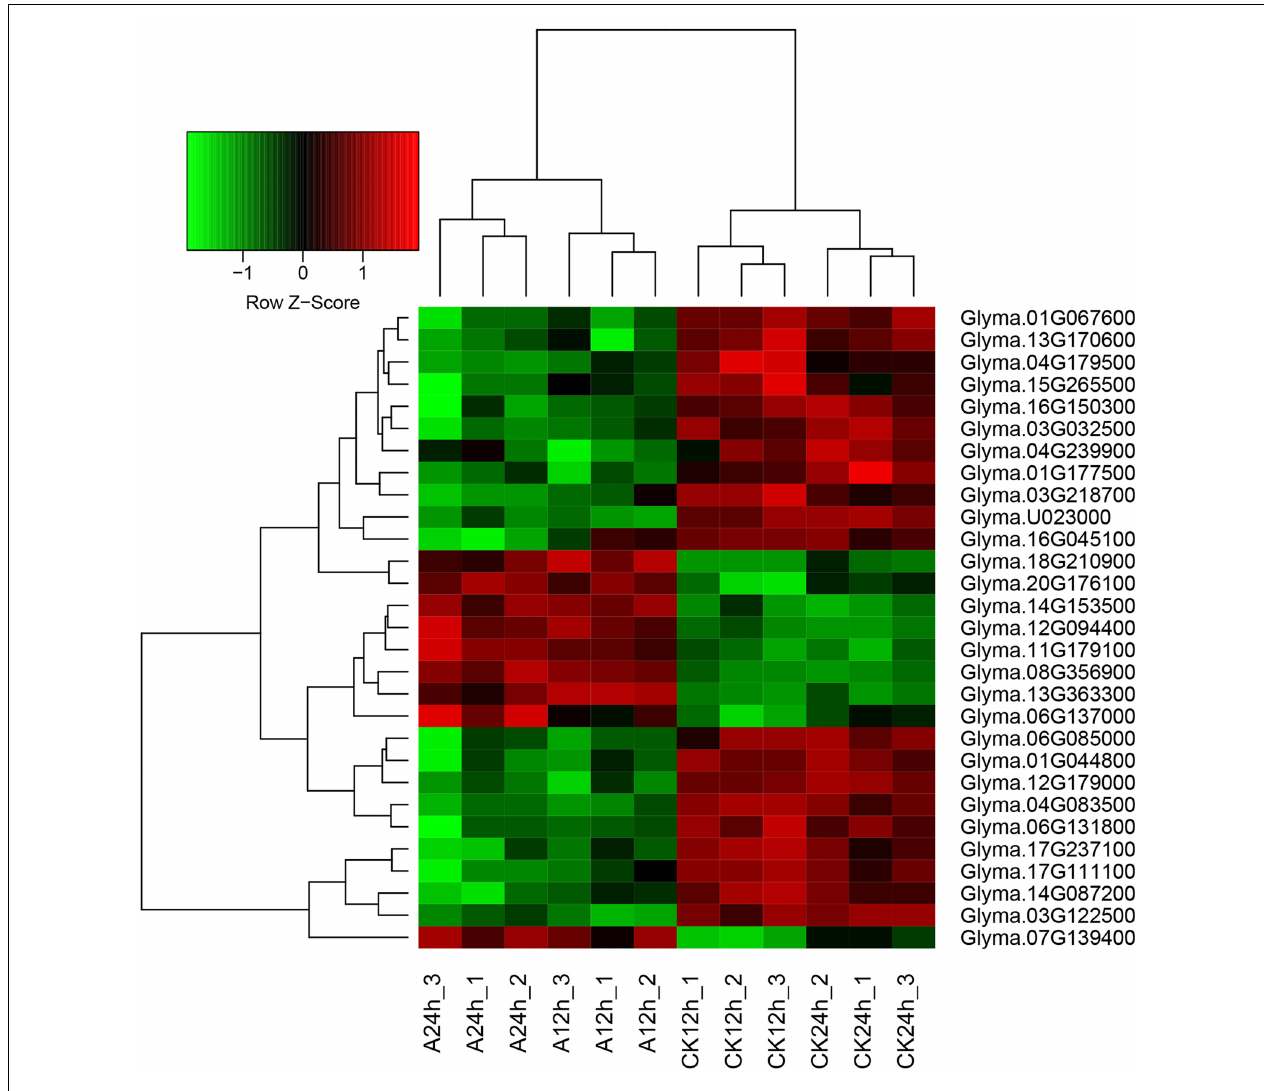
FIGURE 3 | Heatmap of the overlap DEGs between two time points (12 and 24 h). Heatmap was plotted using heatmap.2 function of the R/Bioconductor package gplots. Hierarchical clustering of the DEGs was done by complete method with Euclidean distance. The gene expression levels were transformed by log 2 (FPKM + 1) and the values were centered and scaled in row direction. X -axis, samples; Y -axis, differentially expressed gene